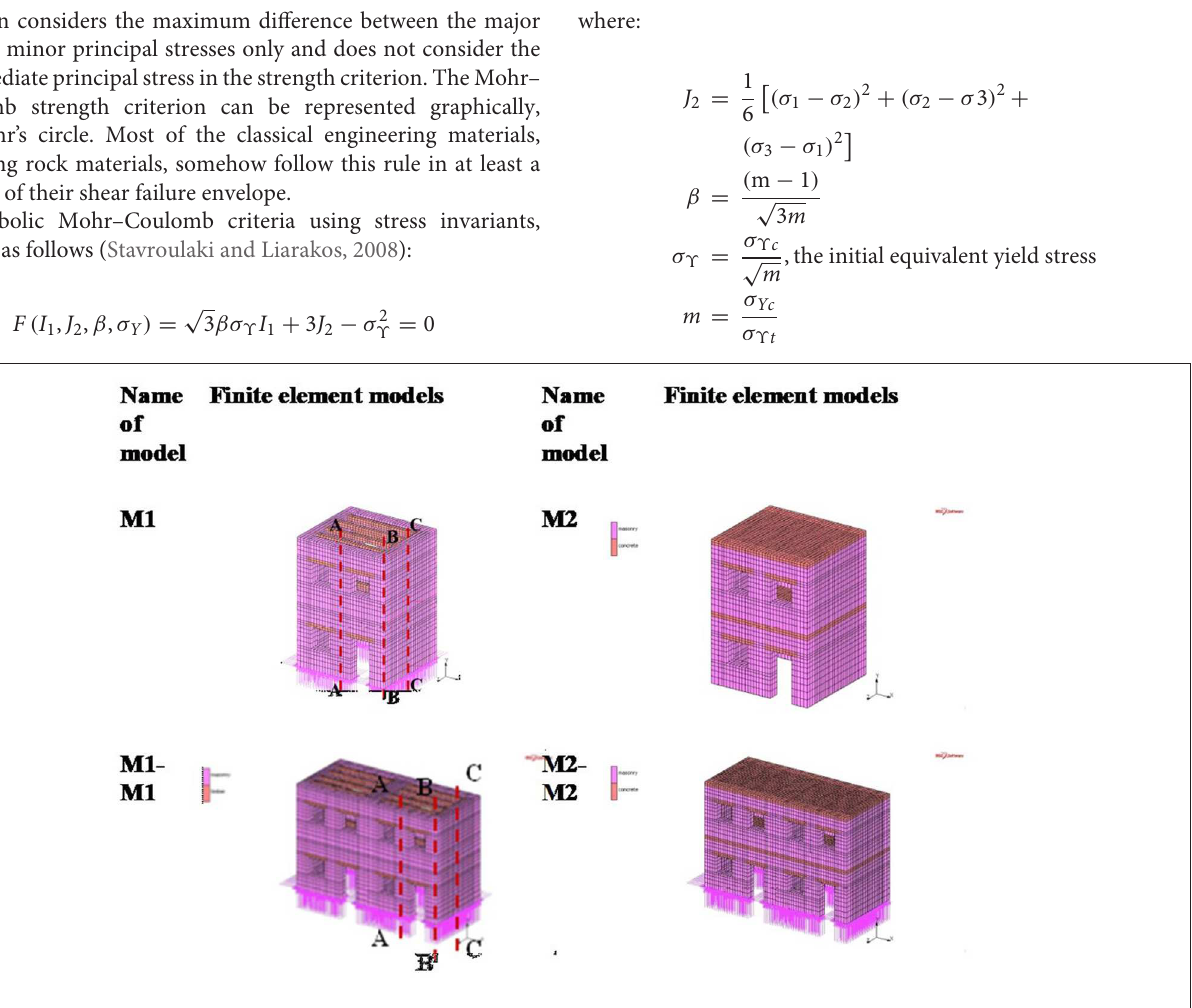
Frontiers in Built Environment |